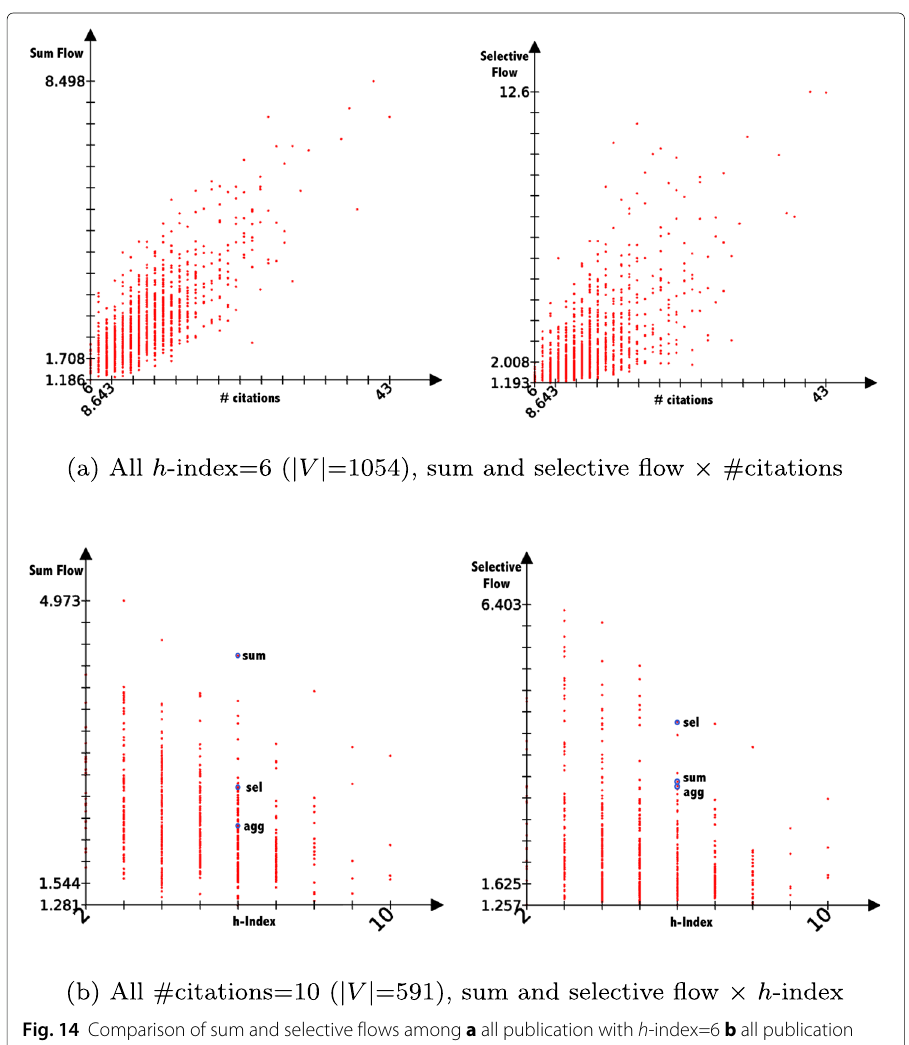
Fig. 14 Comparison of sum and selective flows among a all publication with h -index=6 b all publication with #citations = 10. Circledinblue are the publications with the maximum aggregated, selective and